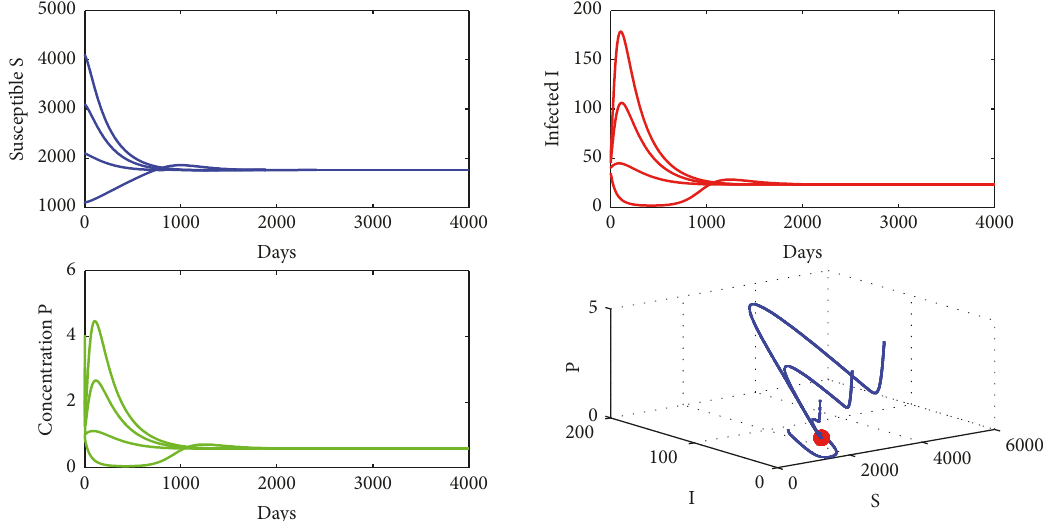
Figure 3: Demonstration of the global stability of the endemic equilibrium 𝐸 ∗ for 𝑅 0 = 3.4201 > 1